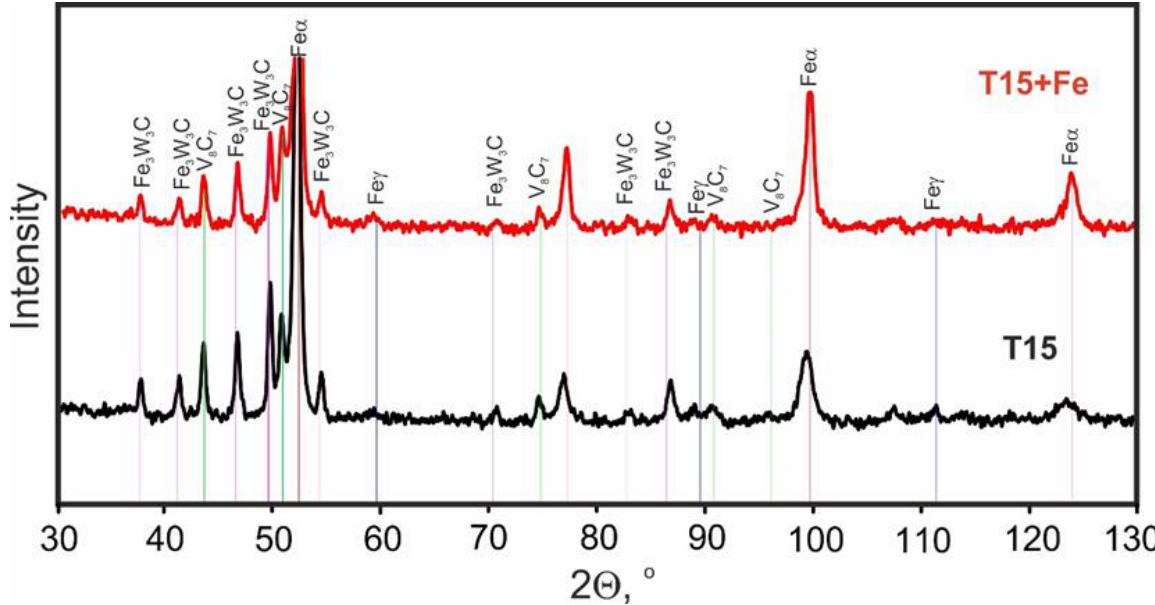
Figure 12. X-ray diffraction pattern of spark plasma sintered T15 and T15+50Fe materials.